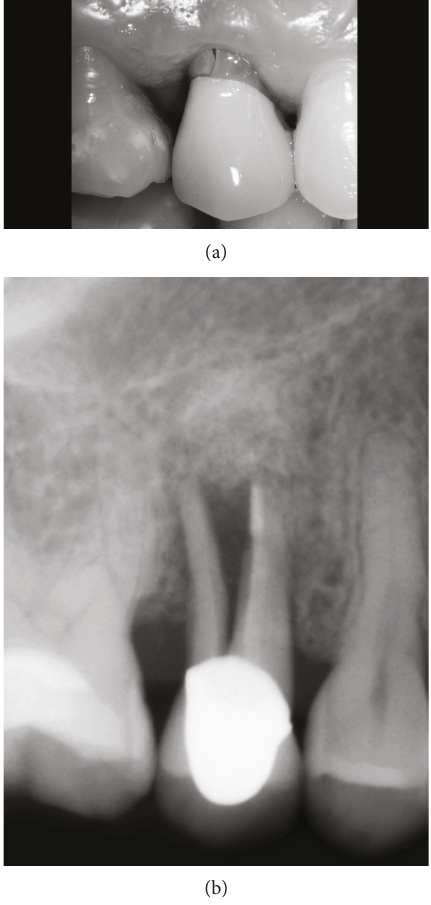
Figure 9: Clinical (a) and radiological (b) presentation of the vertical root fracture: splitting of the premolar root into two halves is clearly